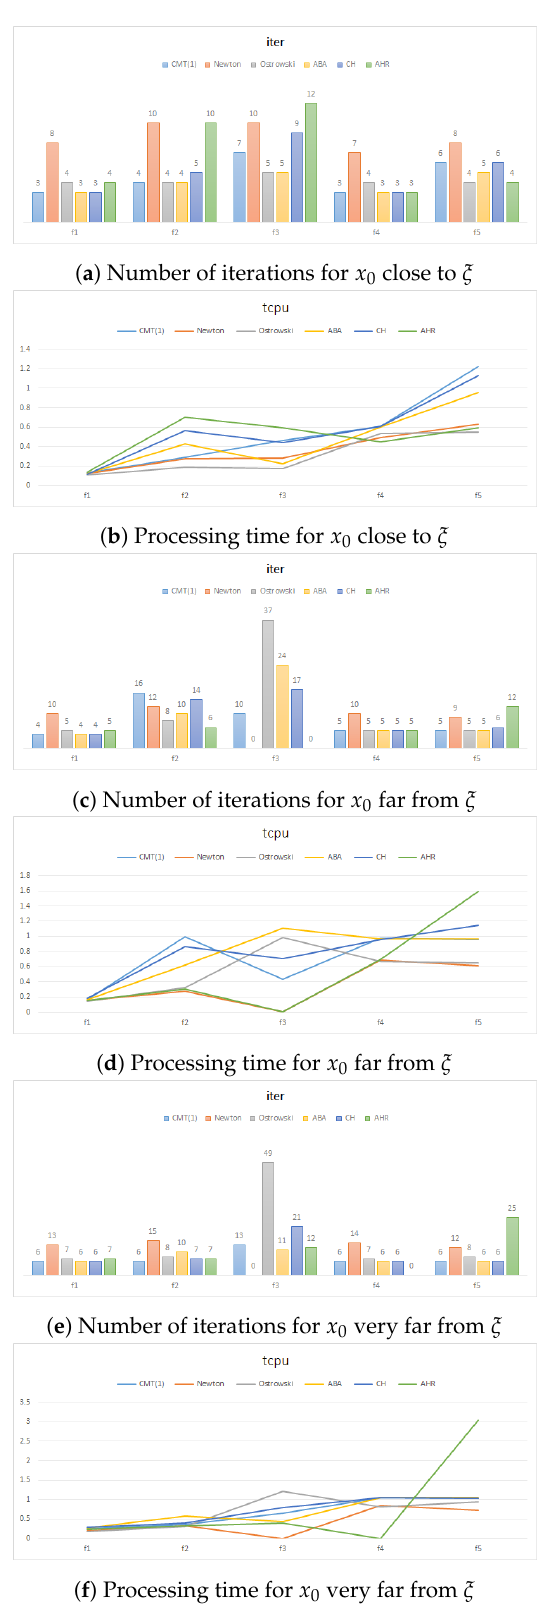
Figure 6. Numerical results of the first